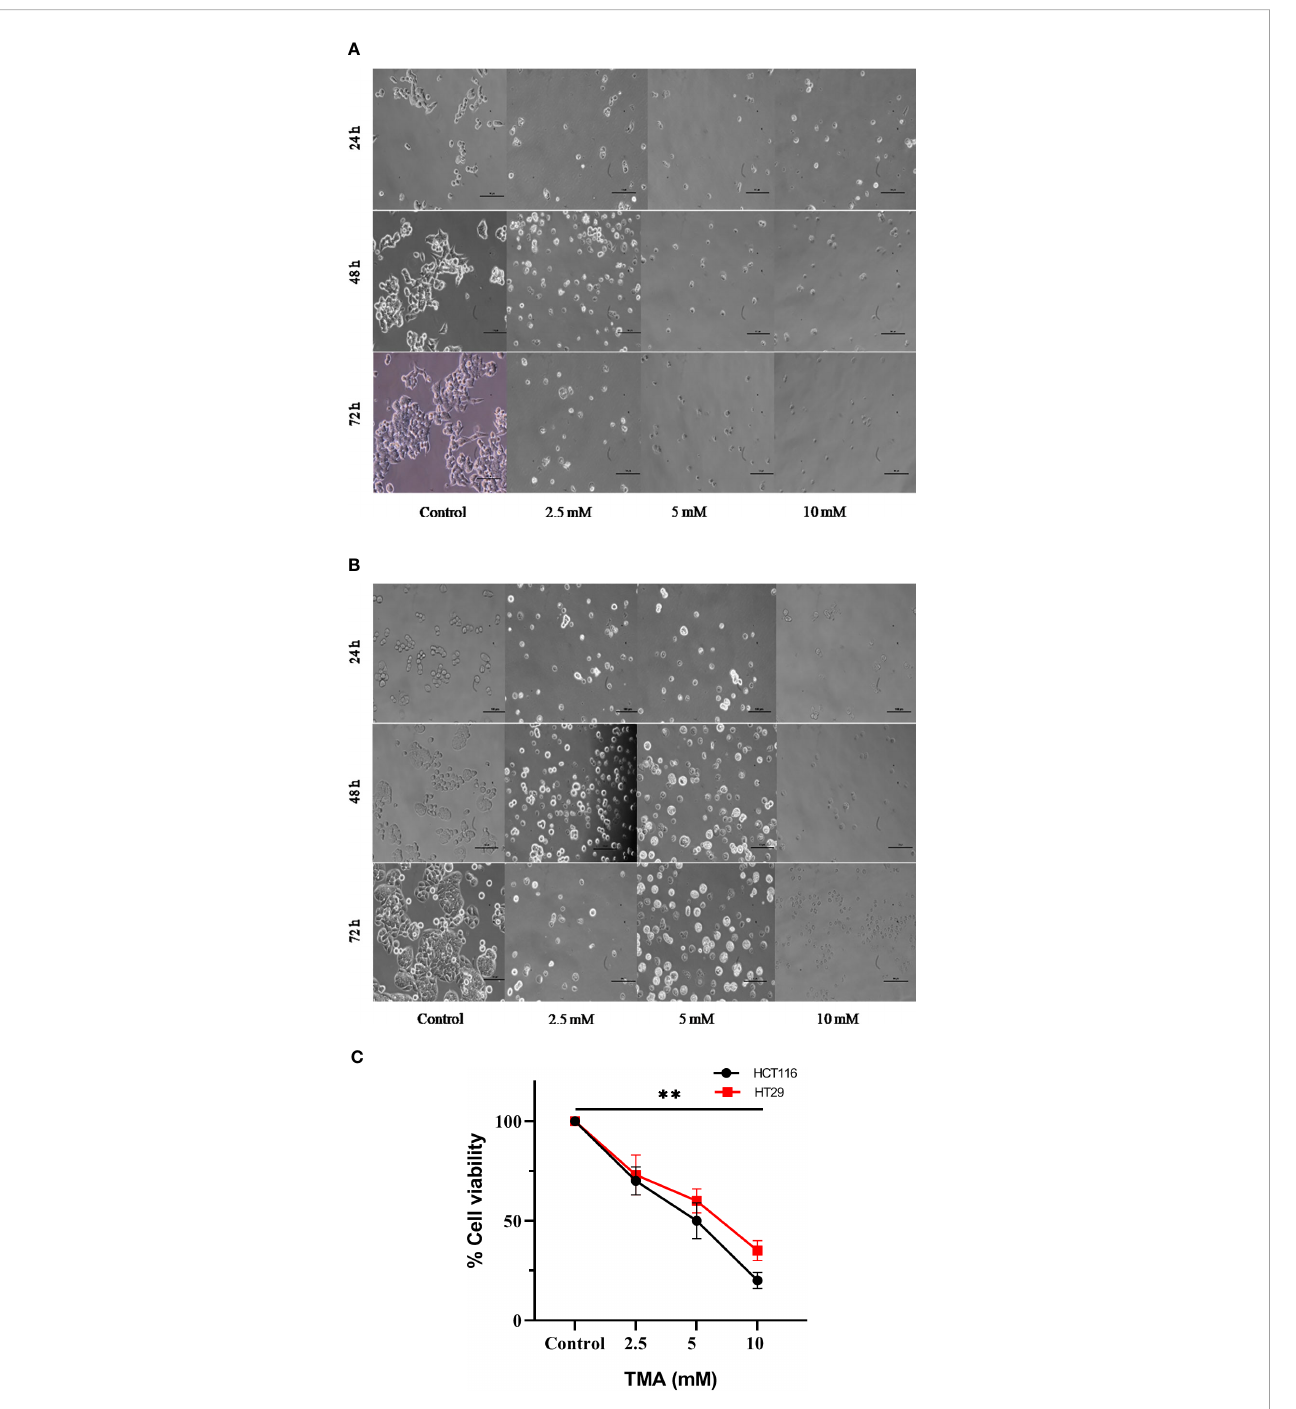
FIGURE 3 Bright fi eld images of HCT116 (A) and HT29 (B) showing changes in cellular morphology, detachment from surface, decreased no. with increase in TMA concentration and time of exposure. Decrease in cell viability was observed after exposure (C) . ** indicates signi fi cant decrease in cell viability compared to control group